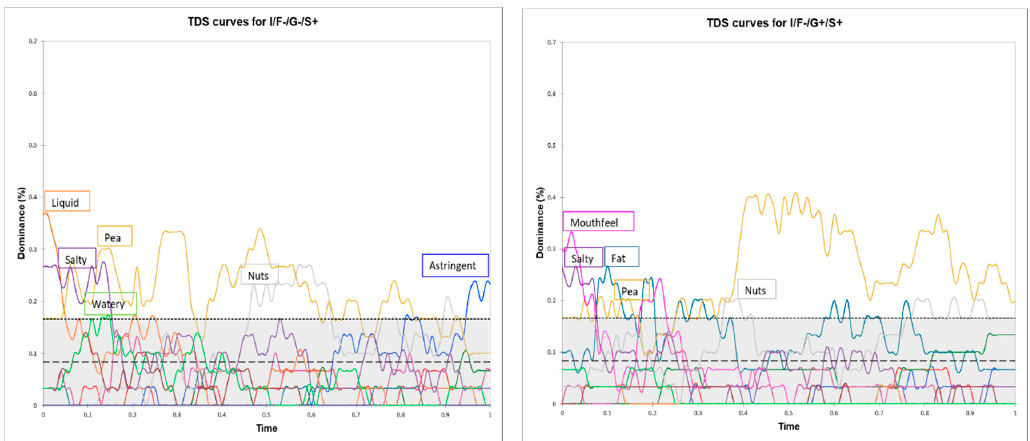
Figure 4. Standardized (mono-intake temporal dominance of sensations) TDS curves for the 12 pea protein-based beverages used in this study. The curves depict attribute dominance over time. The two horizontal lines indicate the relative dominance an attribute could achieve by chance alone (chance level) and the minimum relative dominance an attribute needed to obtain for the result to be significantly different from that expected by chance alone (significance level). Abbreviations: I = isolate, P = pellet, F+ = 1.5% oil, F − = 0% oil, G+ = 0.5% gellan gum, G- = 0.12% gellan gum, S+ = 0.12% salt, and S − = 0.08% salt.